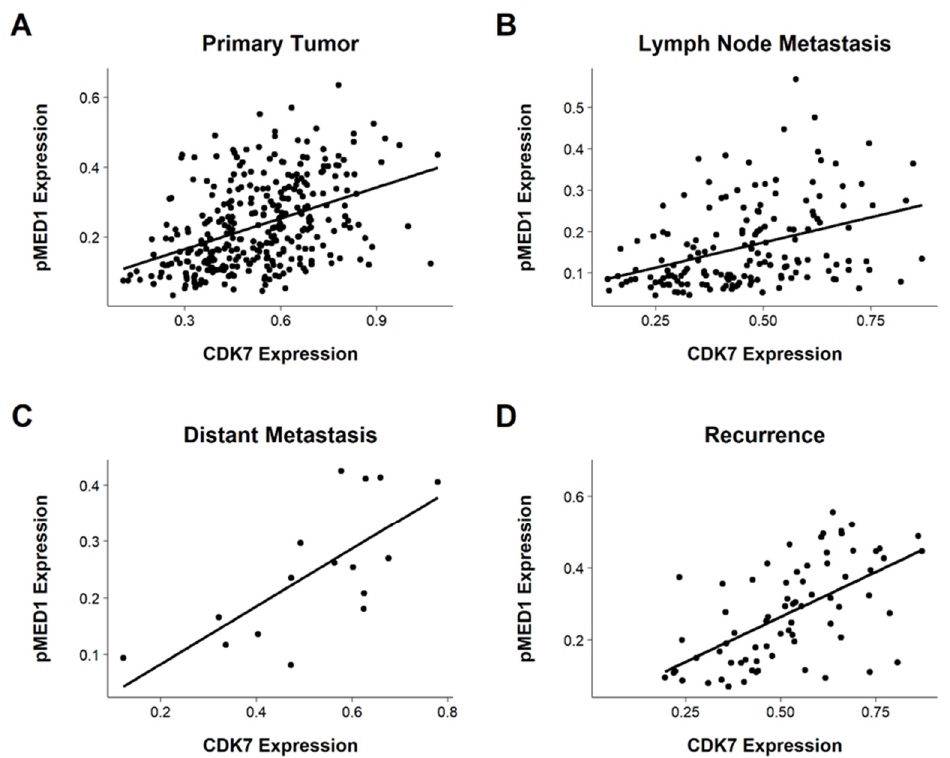
Figure 5. Scatter plot of CDK7 and pMED1 expression in tissue of ( A ) PTs, ( B ) LNs, ( C ) DMs, and ( D ) RDs. A trendline is shown. Irrespective of the tissue type CDK7 and pMED1 levels showed a significant correlation (DMs p = 0.0019, the rest p < 0.001), while the PCC ranged from 0.39 for LNs to 0.71 for DMs.